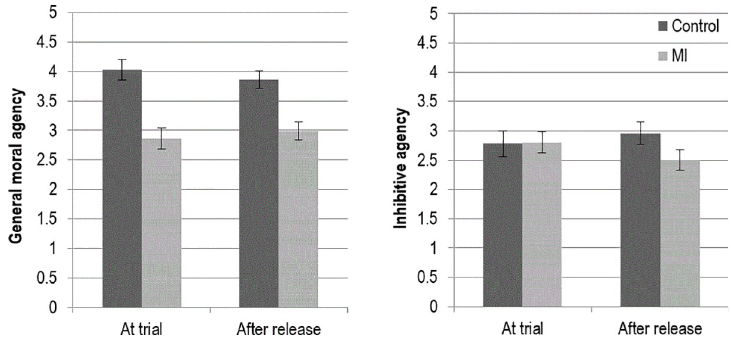
Fig 2. Perceived agency of defendant across experimental conditions (+/- 2